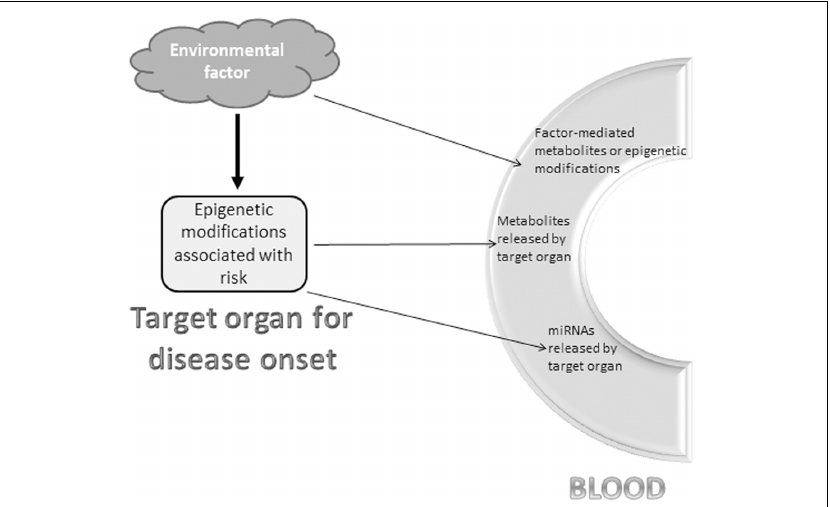
FIGURE 1 | Potential blood markers reflecting epigenetic changes of disease risk. An environmental factor or risk exposure is a powerful means to modify the epigenome in certain organs and cell populations. Three non-exhaustive and non-exclusive options to detect the risk in the blood-stream include (i) blood metabolites or epigenetic modifications directly triggered by the environmental factor that also induced epigenetic modifications in the “at risk” or diseased organ, (ii) metabolites released into the blood-stream by the epigenetically-modified organ with increased risk for disease, and (iii) miRNAs synthesized upon environmental factor-mediated epigenetic modifications in the “at risk” or diseased organ and released into the